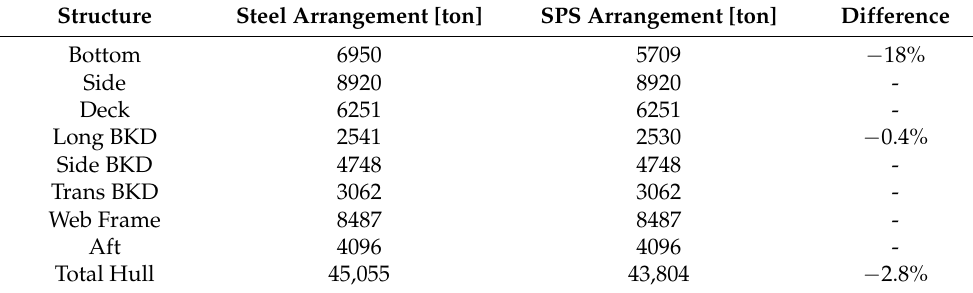
Table 6. Calculations of the weight for each part of the structure for both arrangements.